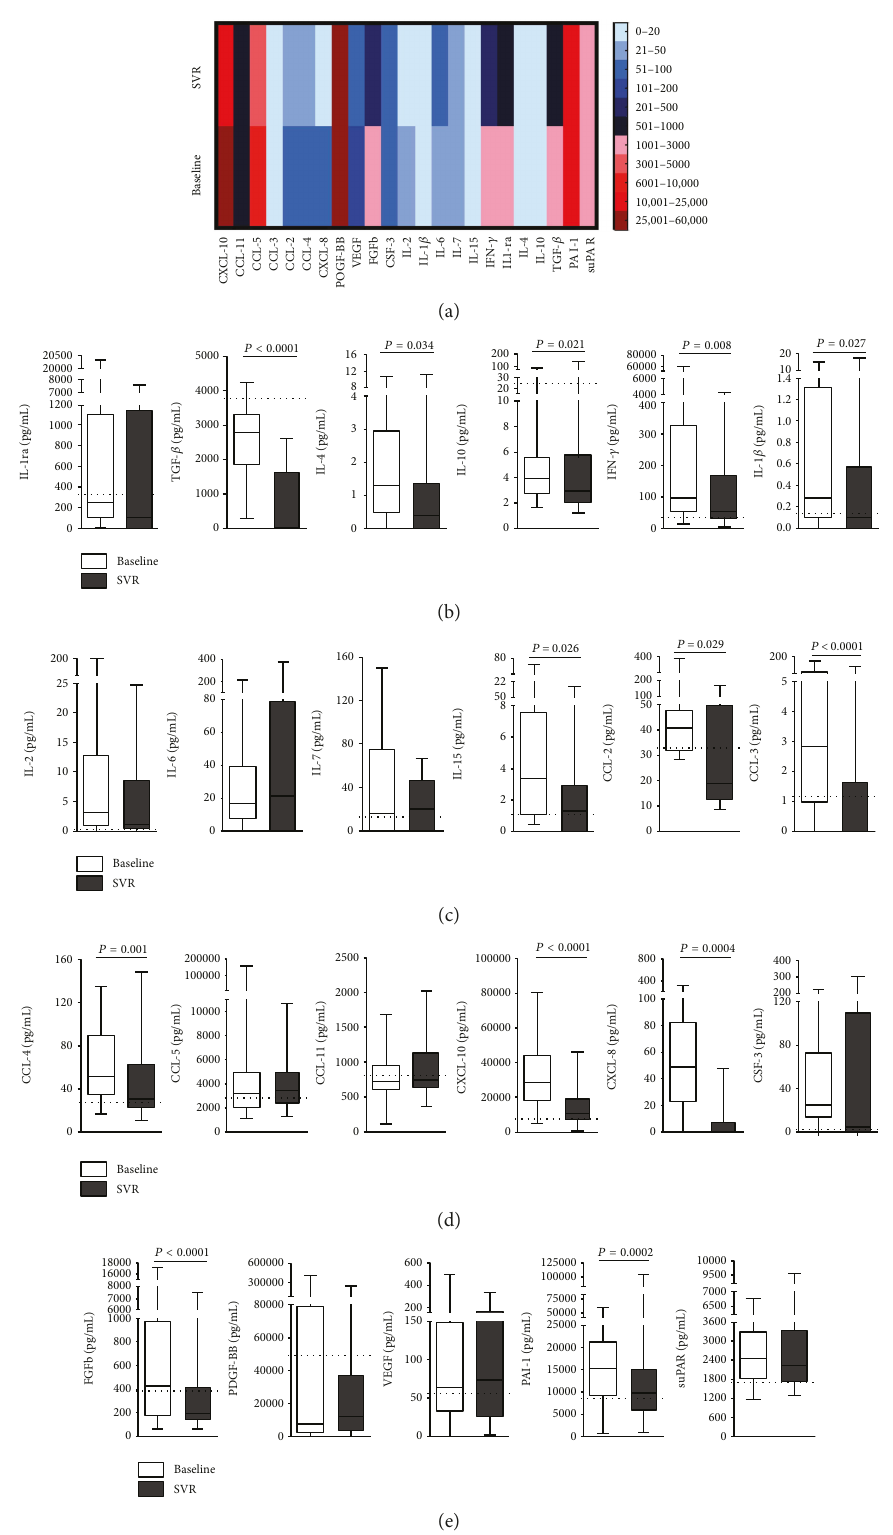
Figure 1: Modulation of cytokines after antiviral therapy represented through (a) heatmaps and box plot graphics of (b) IL-1ra, TGF- β , IL-4, IL-10, IFN- γ , IL-1 β ; (c) IL-2, IL-6, IL-7, IL-15, CCL-2, CCL-3; (d) CCL-4, CCL-5, CCL-11, CXCL-10, CXCL-8, CSF-3; and (e) FGFb, PDGF- BB, VEGF, PAI-1, and suPAR serum levels at baseline and SVR. Dashed lines mean values of HCV noninfected controls. Statistical signi fi cance was assessed by Wilcoxon test or paired t -test ( P < 0 05